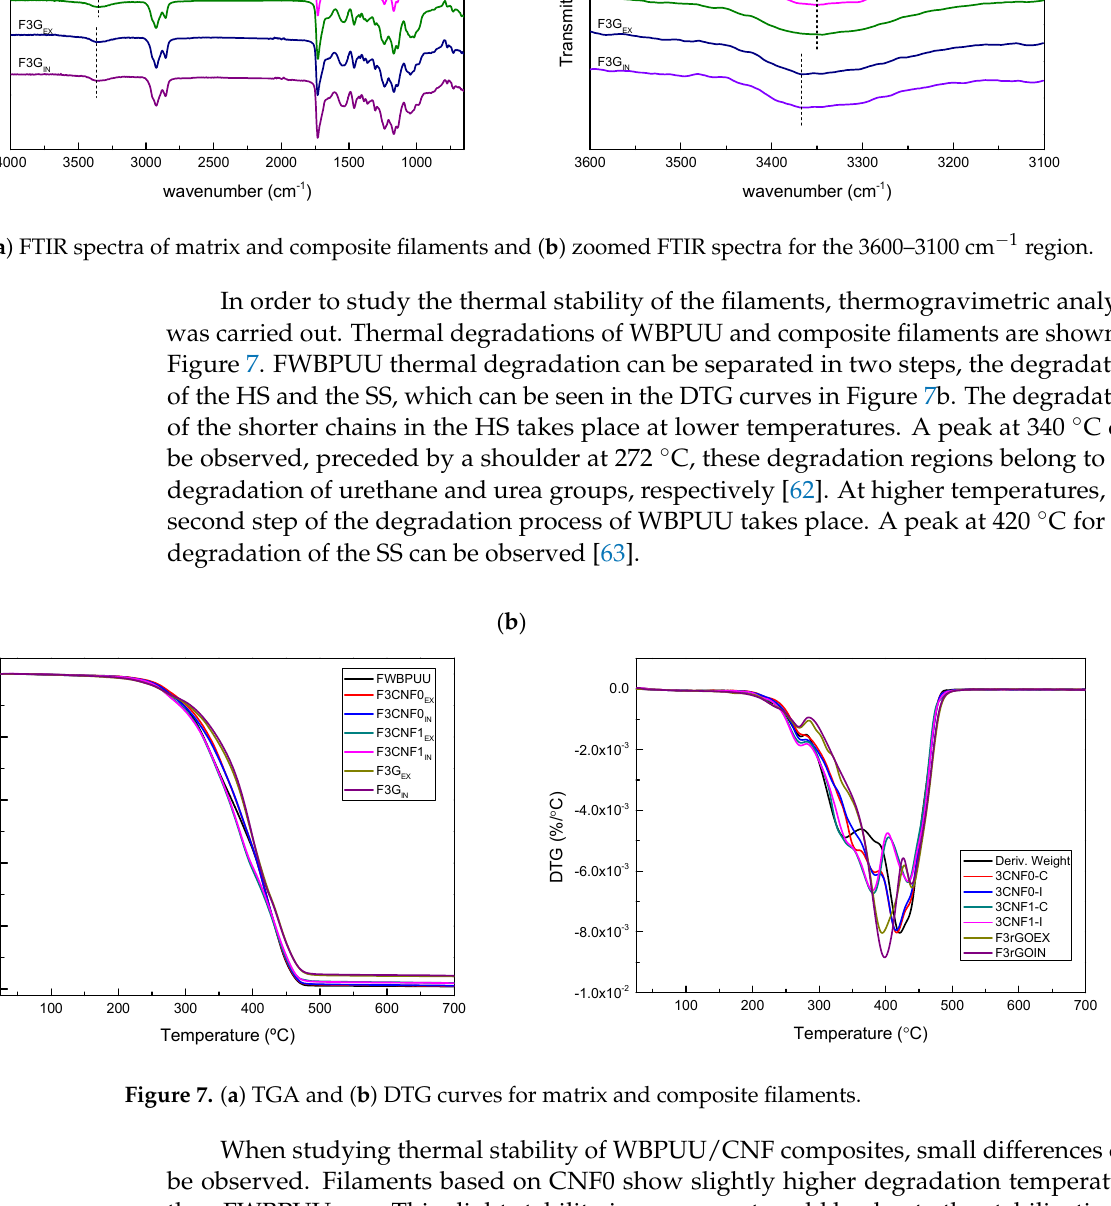
Figure 6. ( a ) FTIR spectra of matrix and composite filaments and ( b ) zoomed FTIR spectra for the 3600–3100 cm − 1 region.